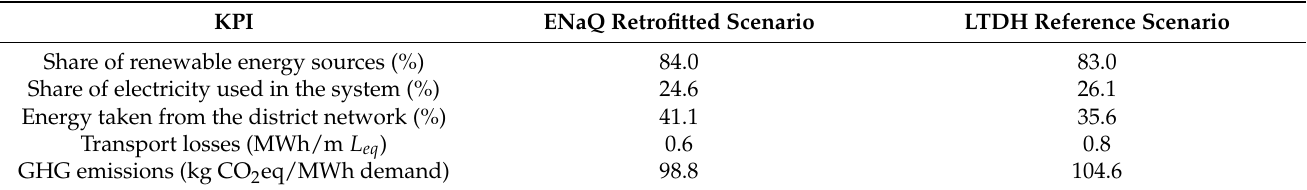
Table 5. KPI modified to compare ENaQ retrofitted and LTDH reference